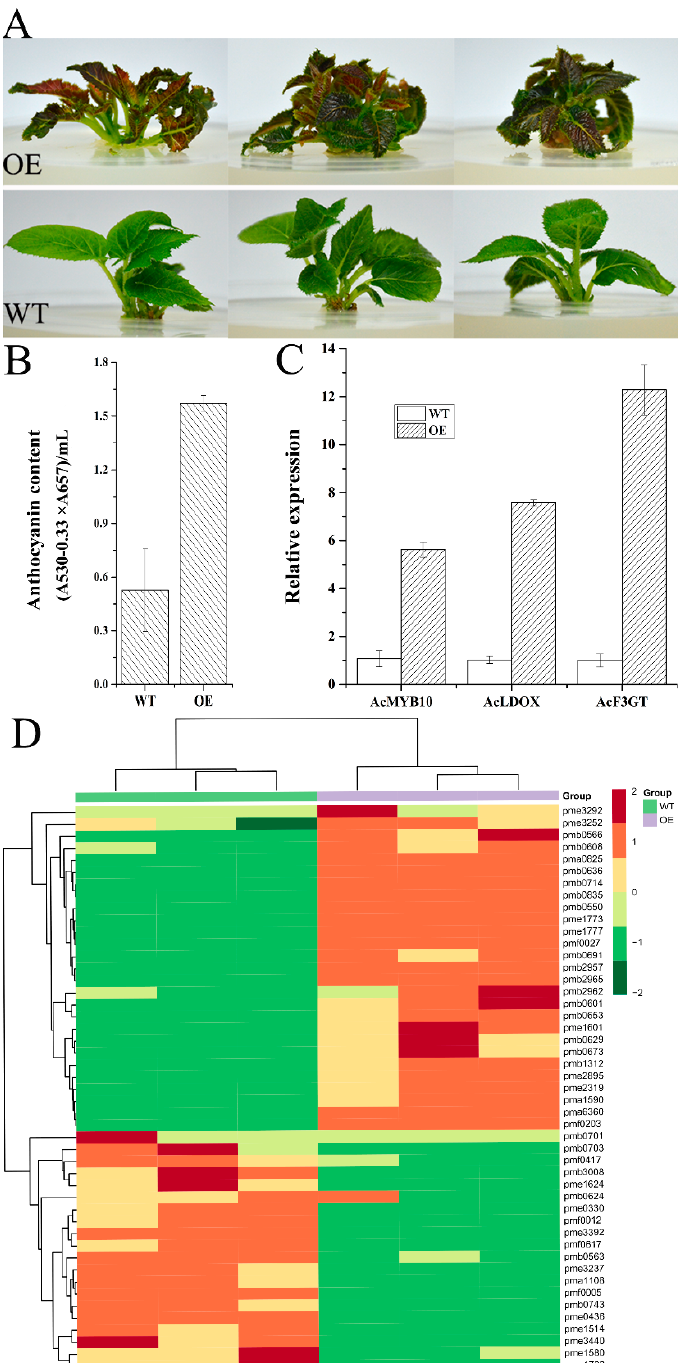
Figure 6. Wild type (WT) and transgenic ‘Hongyang’ (OE) expressing AcMYB10 under the control of the 35S promoter. ( A ) Phenotypes of transgenic and wild-type ‘Hongyang’ kiwifruit. ( B ) Anthocyanin content in transgenic kiwifruit leaves. ( C ) Expression level of AcMYB10 , AcLDOX , AcF3GT in wild-type and transgenic kiwifruit leaves. ( D ) Heat map visualization of flavonoid metabolites. Each metabolite is represented by a single row. Dark red indicates relatively high abundance, whereas metabolites with relatively low abundance are shown in dark green (color key scale on the right of the heat map).